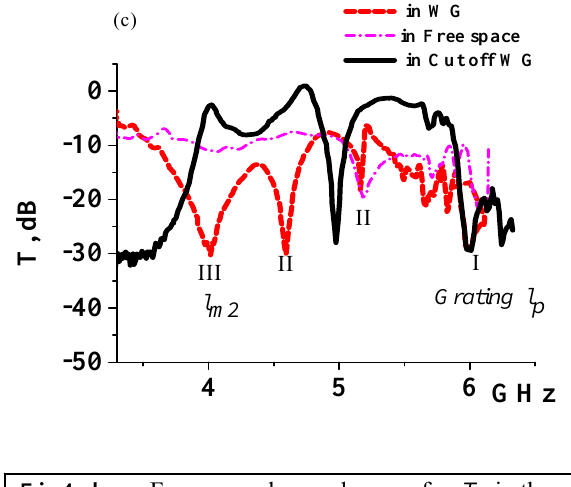
Fig.4a,b,c. Frequency de pendences of T in th e presence of “ Grating -single lo ngitudinal cu t-wire” metastructure with l p =21mm, s =0.2mm in WG (dashed) a nd c utoff WG (s olid), in free space (das h dot): (a) l m1 =26mm and (b) free s pace (A-direction), (c) l m2